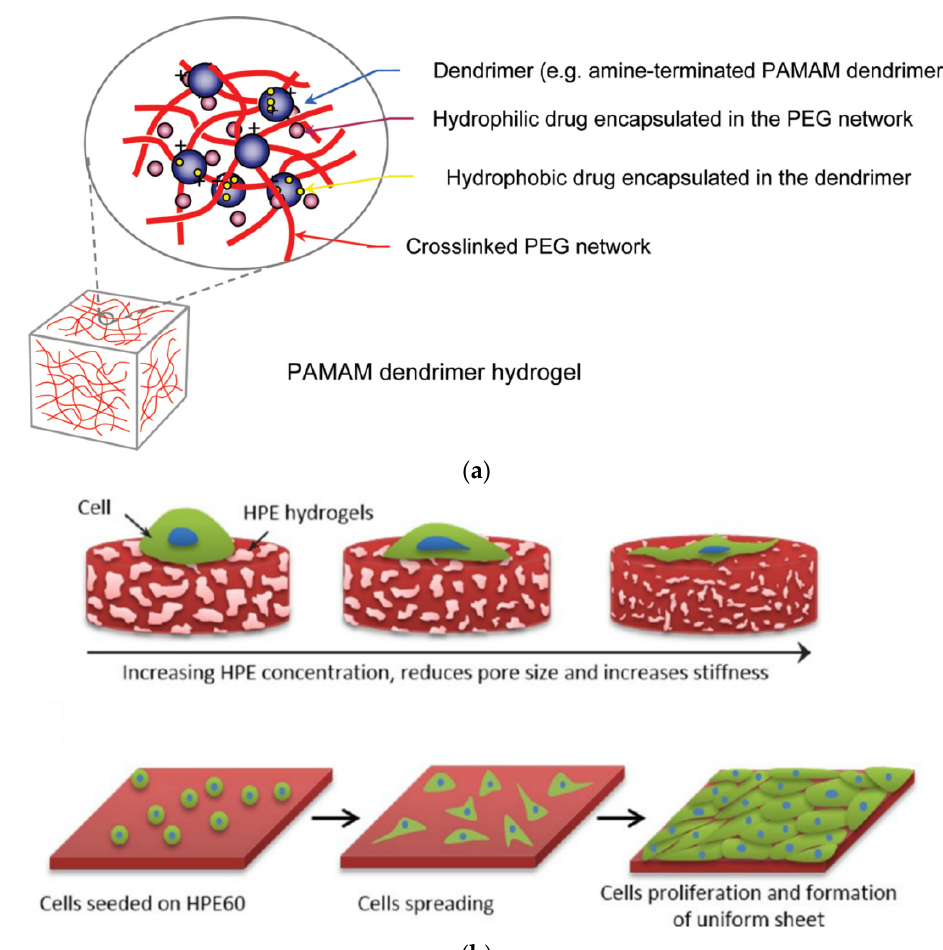
Figure 8. ( a ) Schematic of a cross-linked PAMAM dendrimer network. Reproduced with permission from [140]. Copyright: American Chemical Society. ( b ) Schematics showing the increase in cell adhesion and spreading can be attributed to the higher stiffness of hydrogels resulting from an increase in HPE concentration. The controlled cell adhesion properties of HPE60 can be utilized to fabricate uniform cell layers. Reproduced with permission from [141]. Copyright: American Chemical Society.